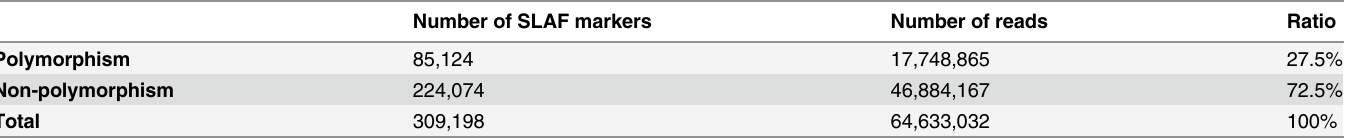
Table 1. Initial detection of SLAF